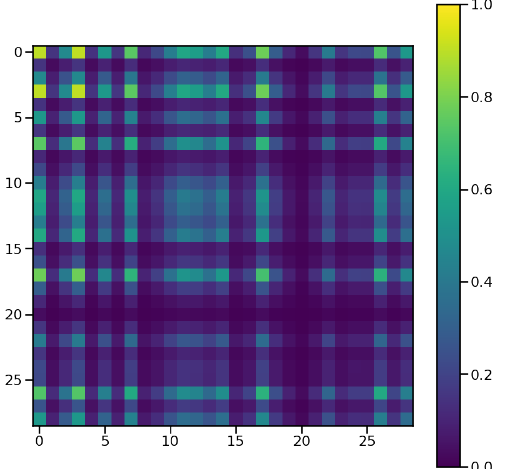
Figure 4. Feature image